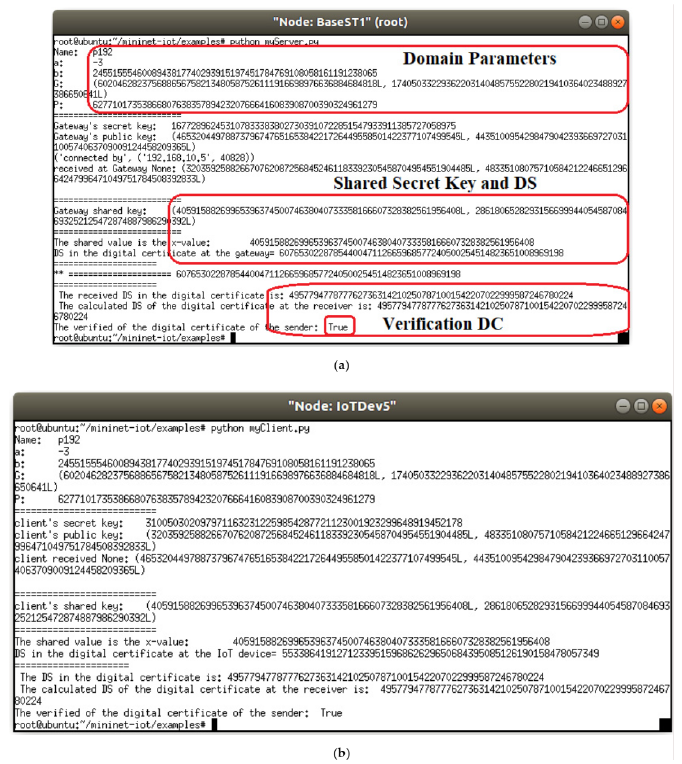
Figure 4. Verification of valid DC ( a ) BaseST1; ( b ) IoTDev5.